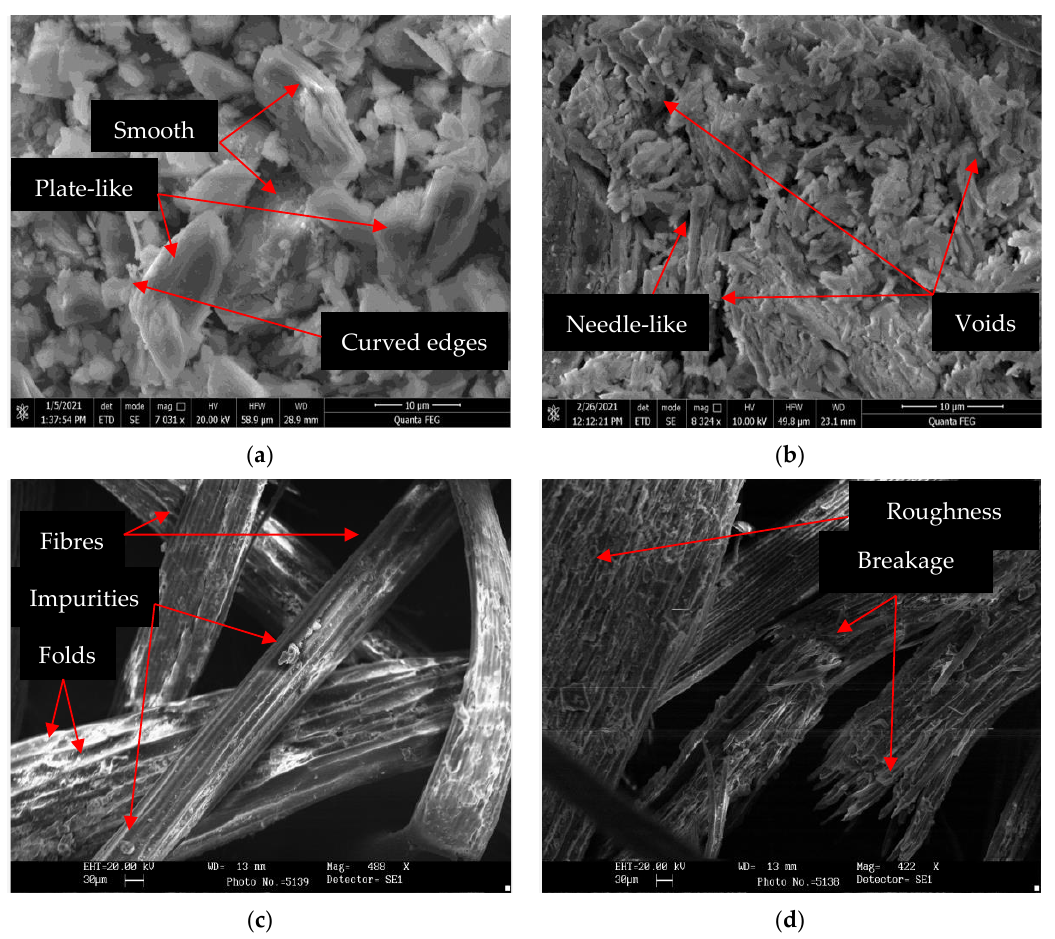
Figure 6. SEM images of ( a ) gypsum, ( b ) plaster, ( c ) Posidonia oceanic fibers (PO), and ( d ) POT with magnification of ( a ) 7031×, ( b ) 8324×, ( c ) 488×, and ( d ) 422×. X-ray diffraction (XRD):the Mestaoua gypsum (GPS) is mainly composed of gypsum (Figure 7). The diffractogram also shows calcite and less bassanite. After dehydration of GPS to produce P, basanite is formed due to water loss, according to Formula (1). The sand (S) is mainly composed of dolomite and calcite (in minor proportions). It also con- tains traces of quartz.